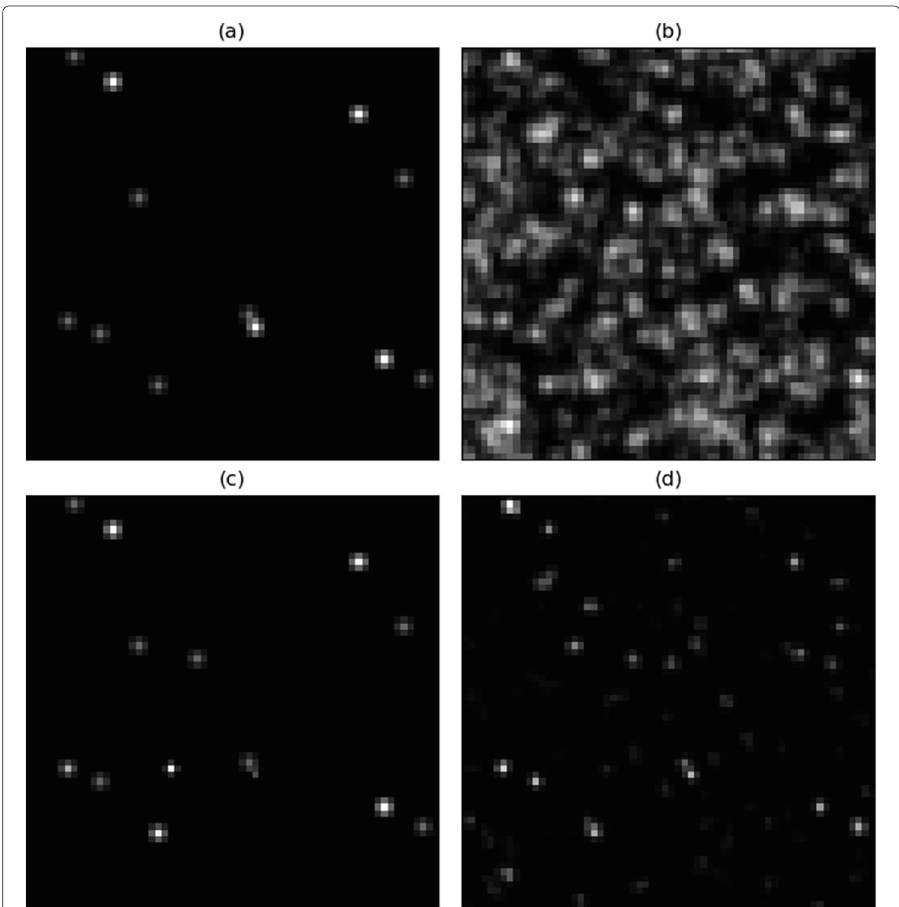
Fig.4 Cross-sectionsofparticlefield, a Syntheticfield, b MLOSfield, c AI-PR, d